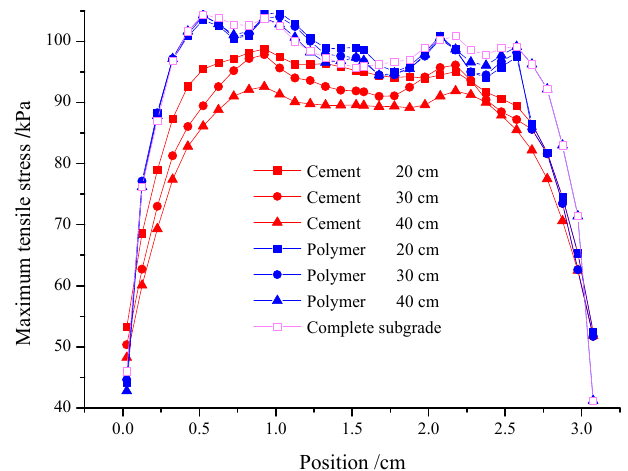
Figure 12. Variation of stress at the bottom of base with different thickness of lifted layer.